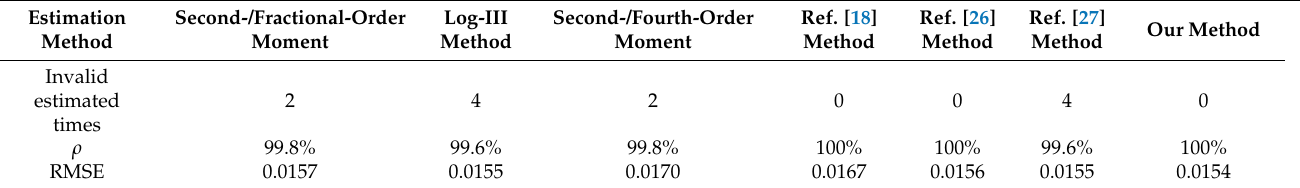
Table 1. The statistics of estimation efficiency and estimation accuracy in simulated K-distribution ( v = 3, k = 0.5).